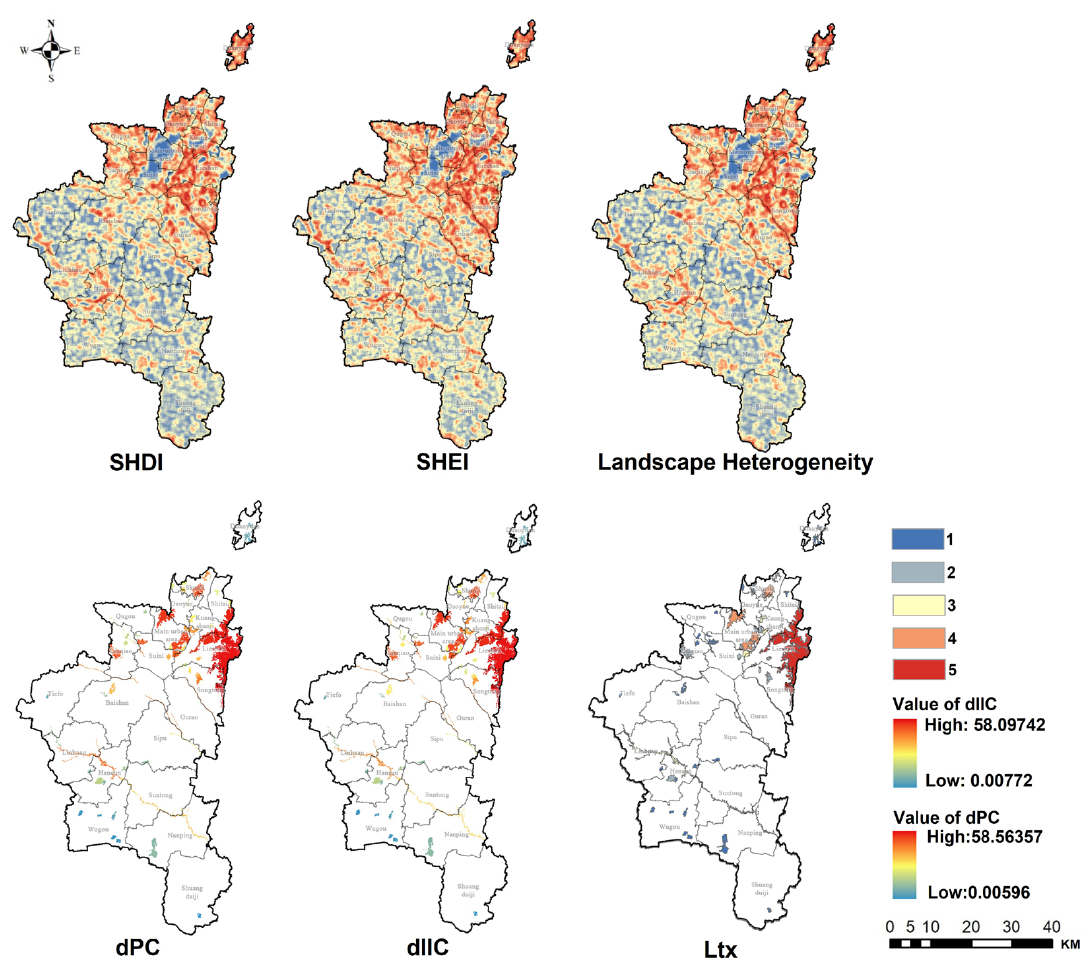
Figure 5. Spatial distribution of ecosystem structure grades in Huaibei City (Grade 1 = lowest; Grade 5 = highest).